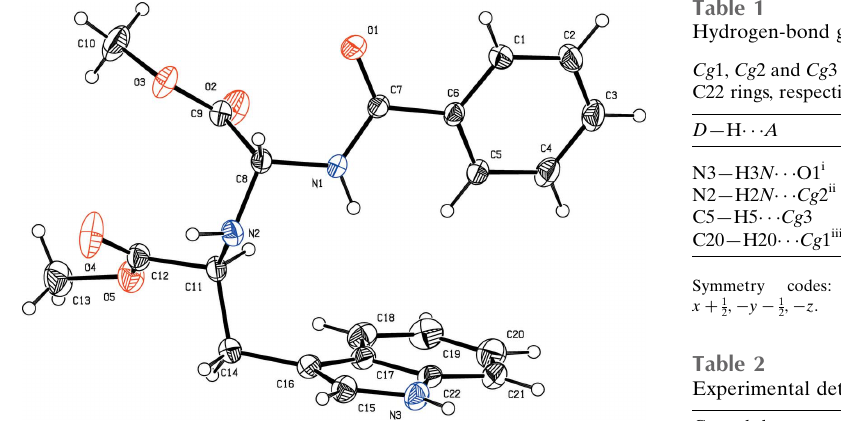
Table 2 Experimental details.